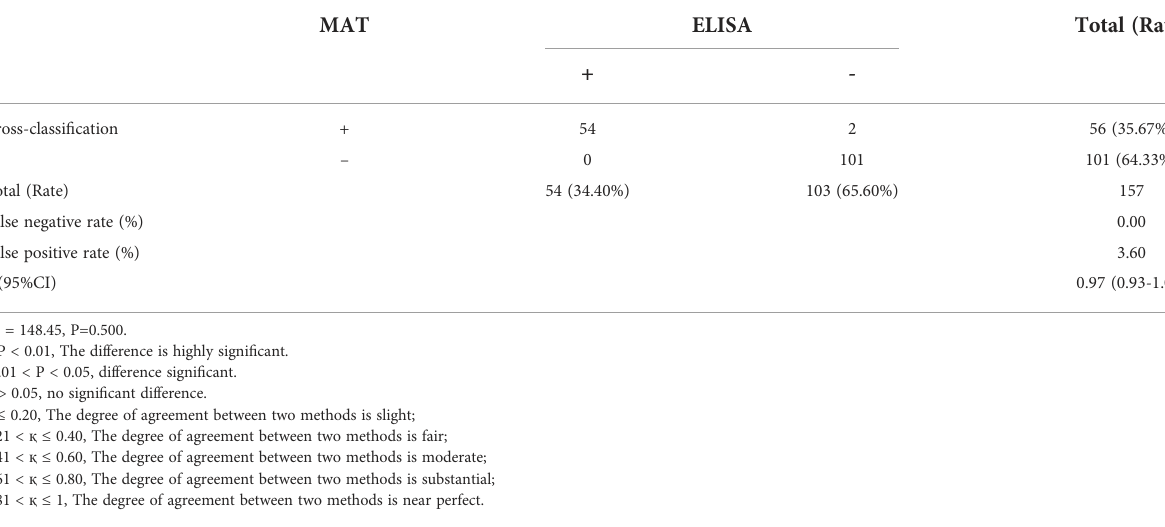
TABLE 3 The cross-classi fi cation and inter-agreement between MAT and ELISA for the detection of T.gondii antibodies in giant panda serum.